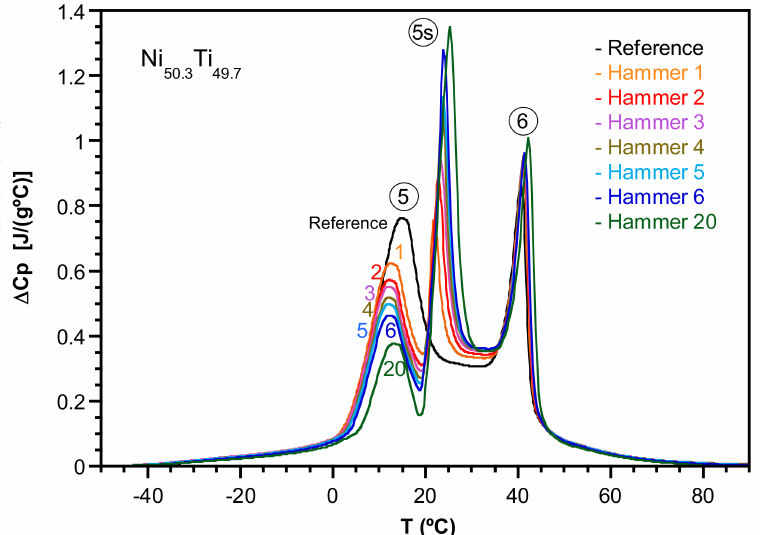
Figure 10. The various “Hammer n ” effects, always on stage 5 and T a = 17 ◦ C, for n = 1–6 and n = 20. In all the studied cases, only the final curves showing the corresponding TME are plotted. The progressive increase of the 5 s peak as a function of n is clearly observed.